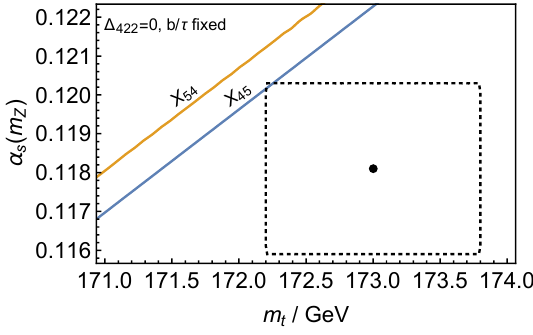
Figure 9 . Predicted correlation between the top quark mass m t and the QCD coupling (cid:11) s ( m Z ) in the 422 theory. The dot and the dotted box show the central value and the 2 (cid:27) range of the observed values,